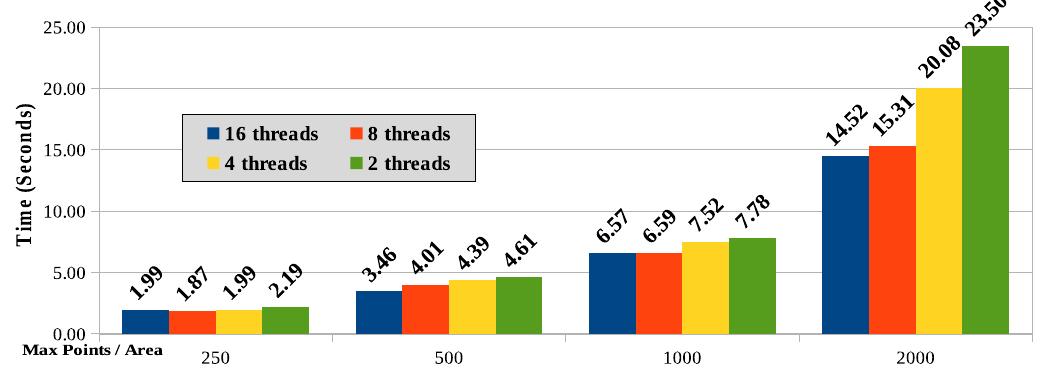
Figure 16. Response times by thread using PL/pgSQL Language. Source: the